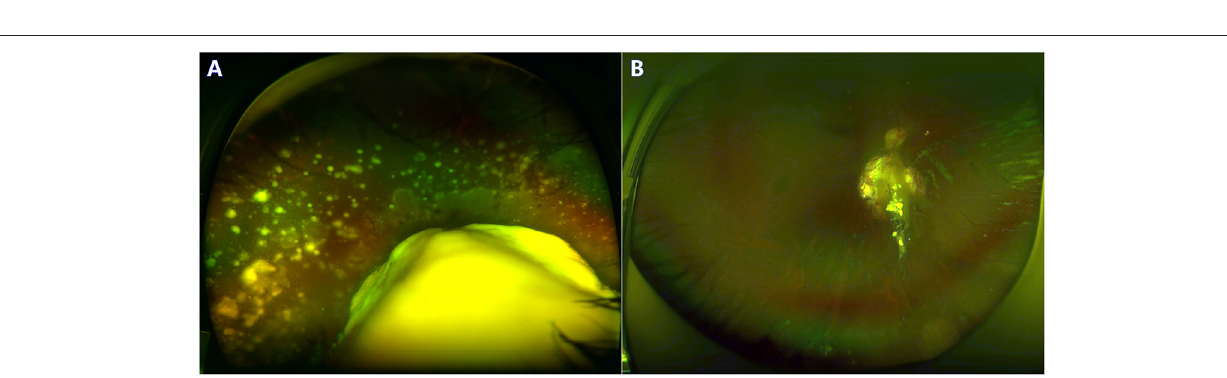
FIGURE 2 | A 3-year-old boy with group D retinoblastoma presented with a large retinal tumor and massive subretinal seeds. The regression of tumor and seeds was noted at the 24-month follow-up. Before (A) and after (B) 3 cycles of primary IAC infusion and laser consolidation treatment.